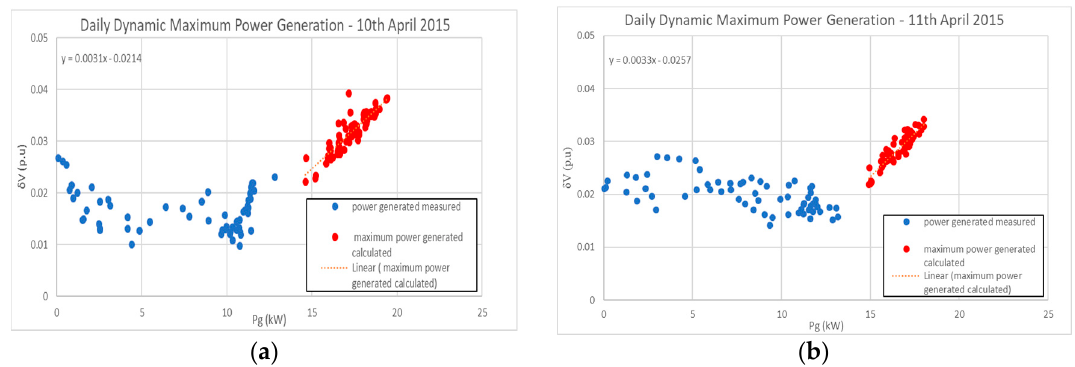
Figure 4. Voltage variation x generated power and the linear dependency in relation to the maximum amount of power calculated by (5) — April 9th, 2015.